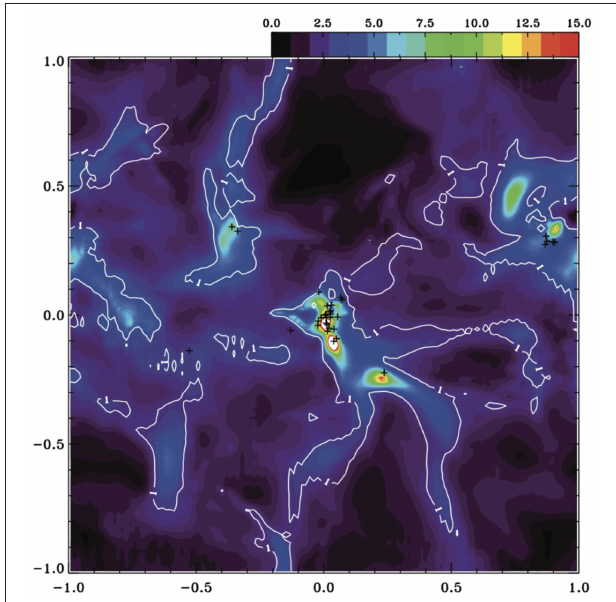
FIGURE 12 | Spatial distribution of column density and mass-to-flux ratio in an initially subcritical and turbulent molecular cloud (Nakamura and Li, 2008). Inside the contour the gas is supercritical and has collapsed at several places. Outside the contour it is still subcritical. Reproduced from Nakamura and Li (2008) with permission of